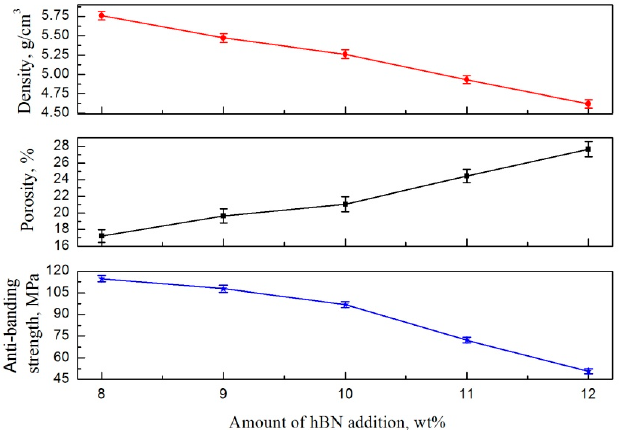
Figure 1. Influence of hBN content on the density, porosity, and flexural strength of NiCr/hBN